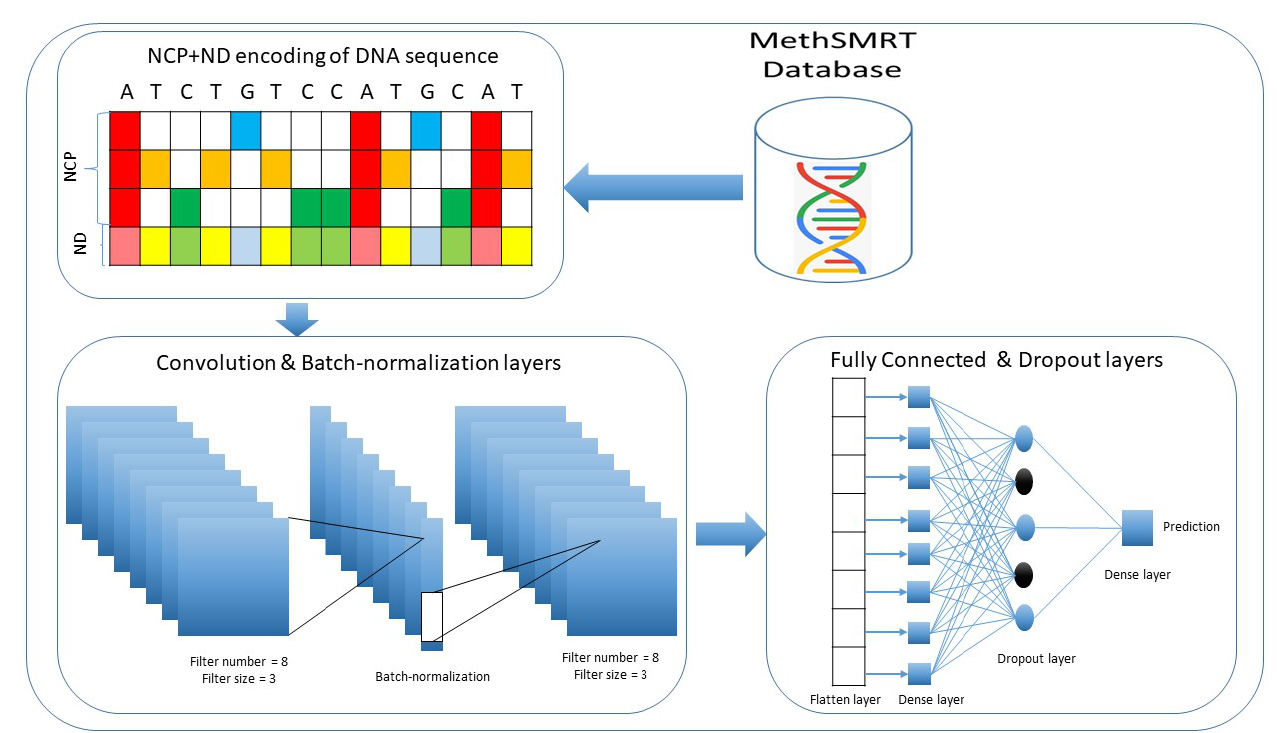
Figure 1. Demonstration of the data-flow and architecture of the proposed model.